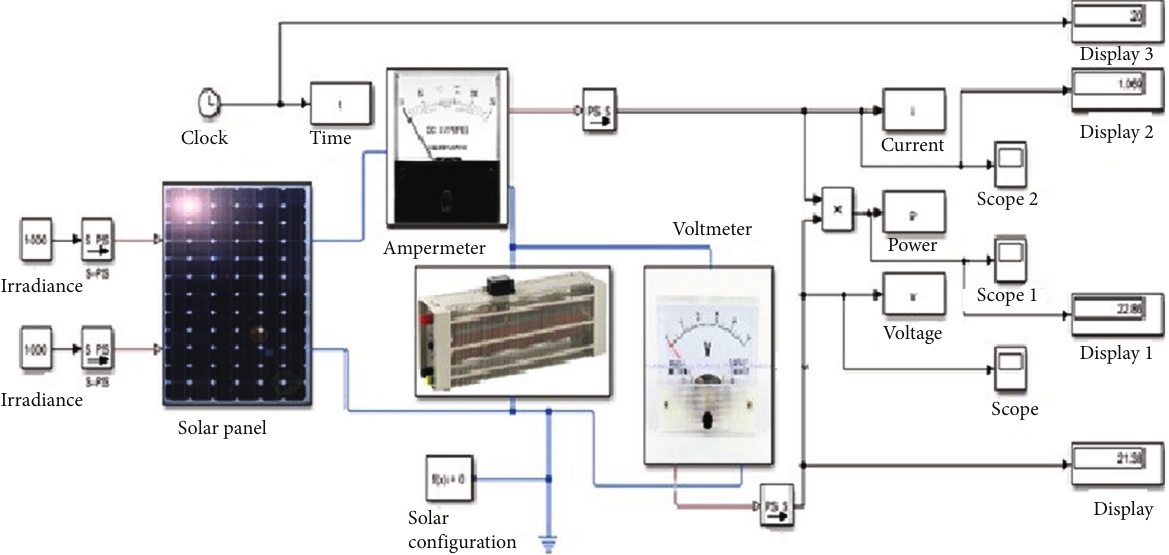
Figure 3: Simulation diagram of a PV module under STC conditions in